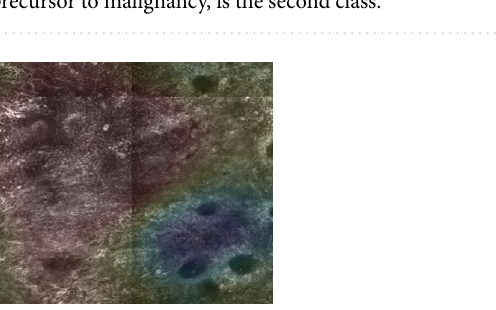
Figure 2. Six cellular morphological patterns classified by clinicians as viewed under reflectance confocal microscopy. For this research, the five leftmost patterns were grouped together into “benign” while “aspecific”, a precursor to malignancy, is the second class.